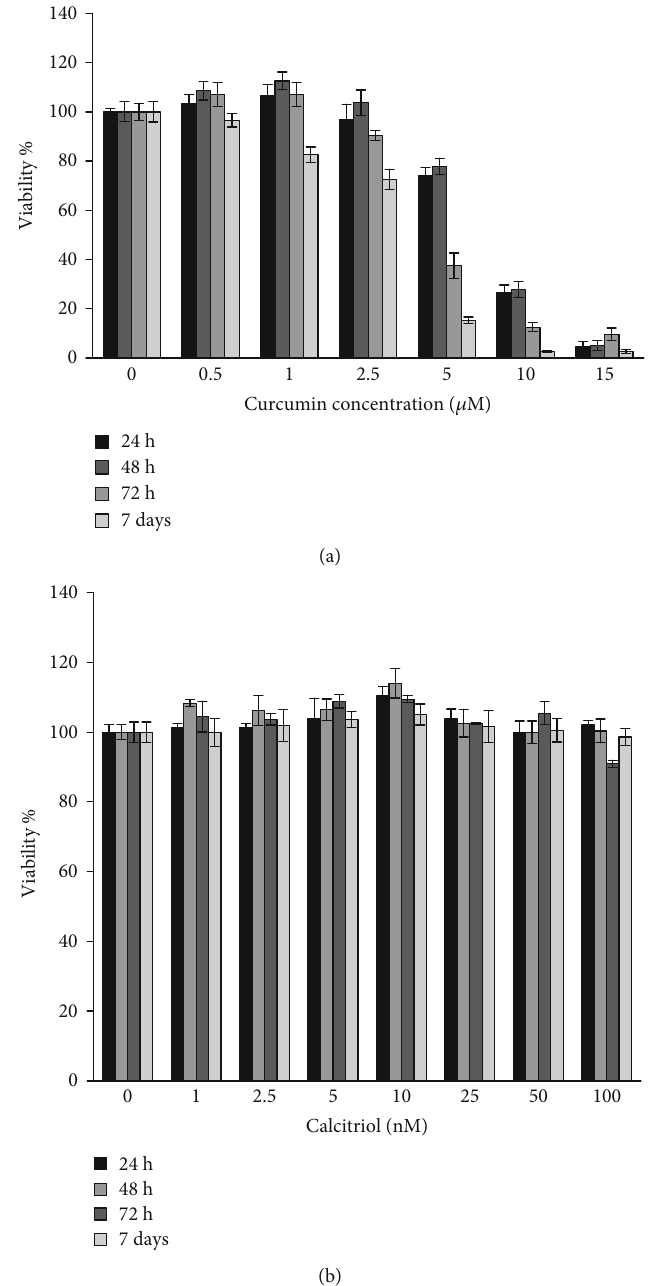
Figure 1: (a) Viability of DPSCs after treatment with curcumin in 24, 48, and 72h and 7 days. (b) Viability of DPSCs after treatment with calcitriol in 24, 48, and 72 h and 7